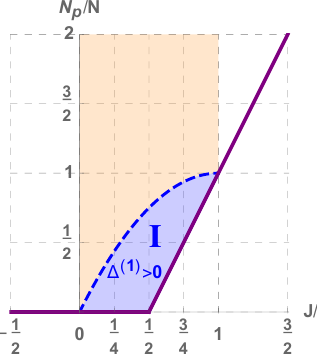
exist (orange and blue regions). In the j + i condenses and (cid:1) (1) > 0. On the dashed line, 1